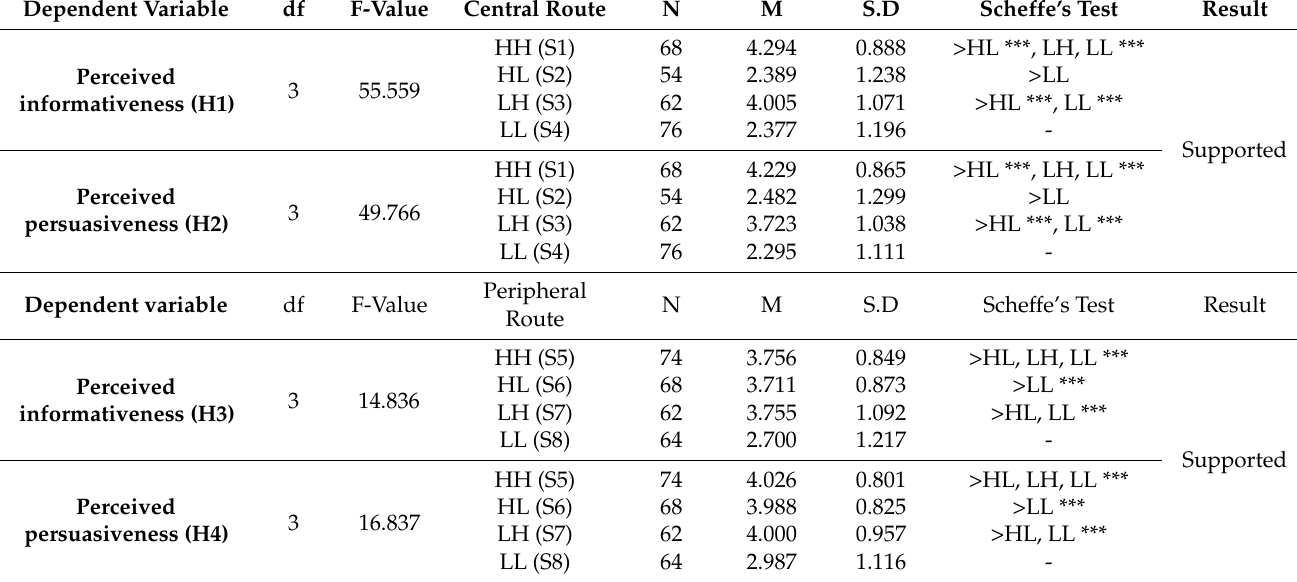
Table 3. Results of one-way ANOVA of